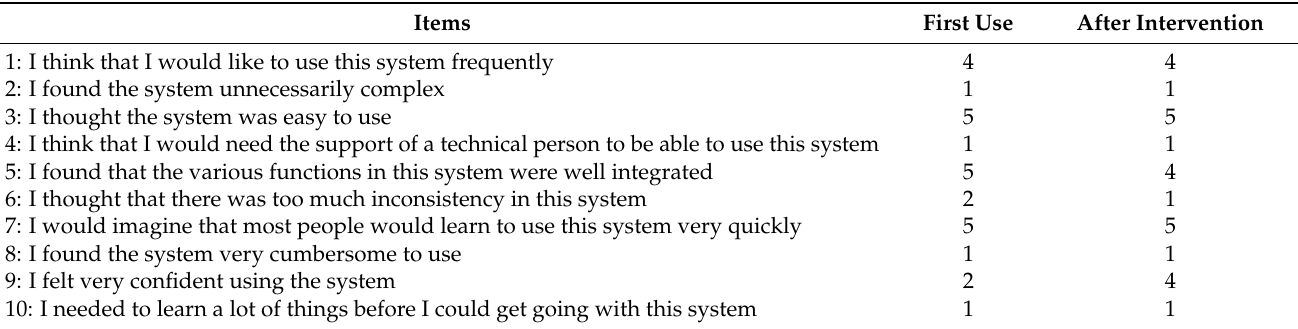
Table 2. SC/ERP + LBT-based ICT system usability